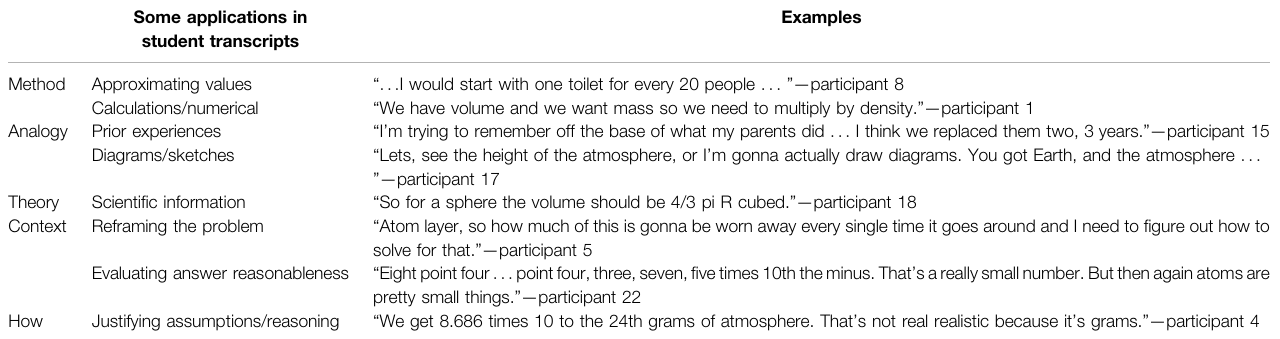
TABLE 3 | Examples of MAtCH applications in student transcripts to better understand how students generally used each MAtCH component in their problem-solving